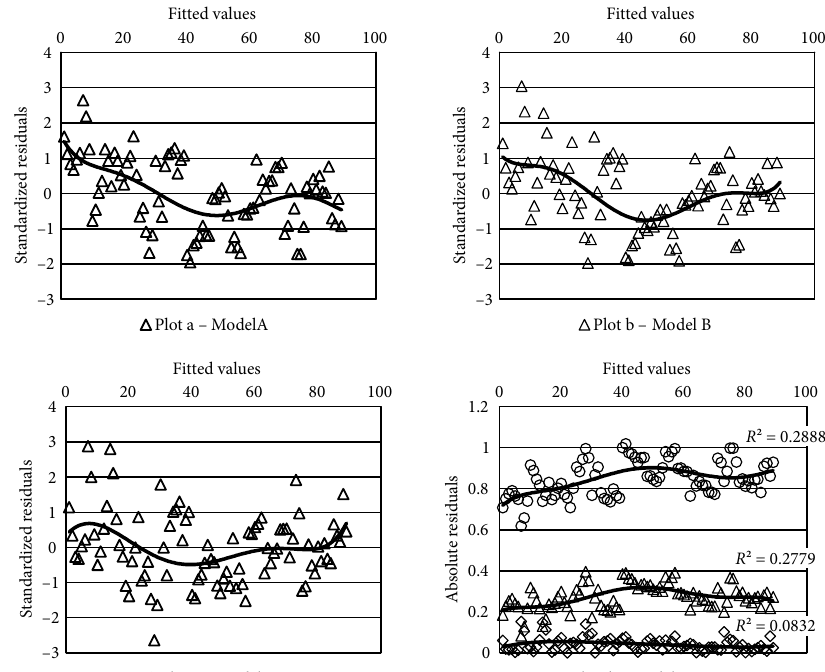
Fig. 2. Residuals